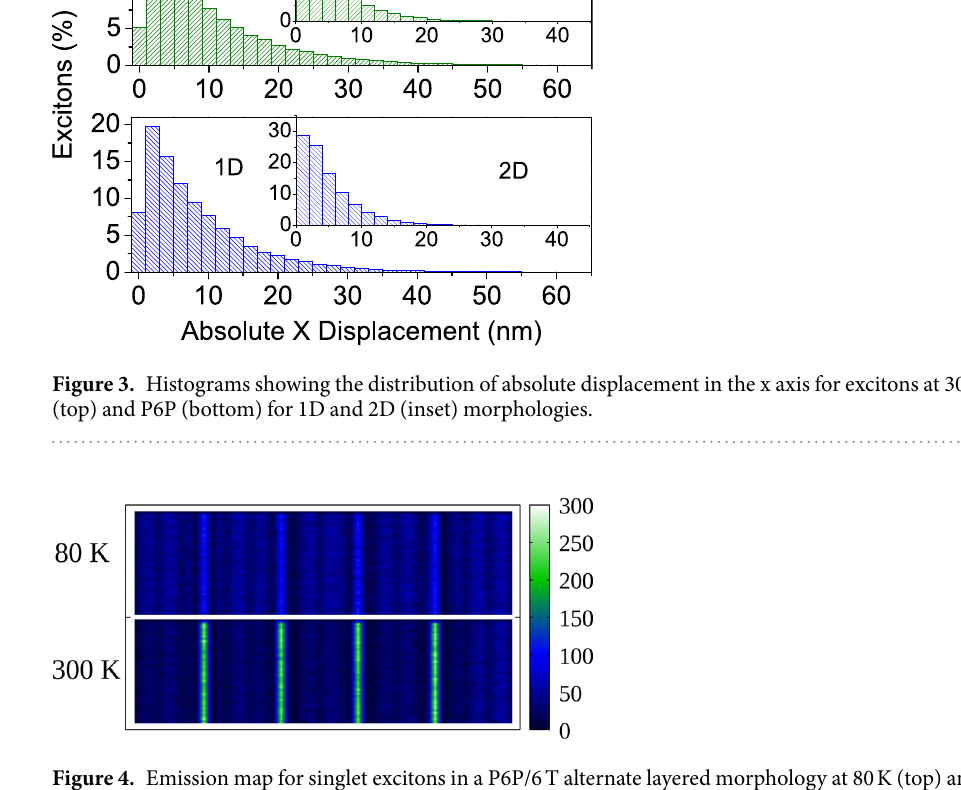
Figure 4. Emission map for singlet excitons in a P6P/6 T alternate layered morphology at 80 K (top) and 300 K